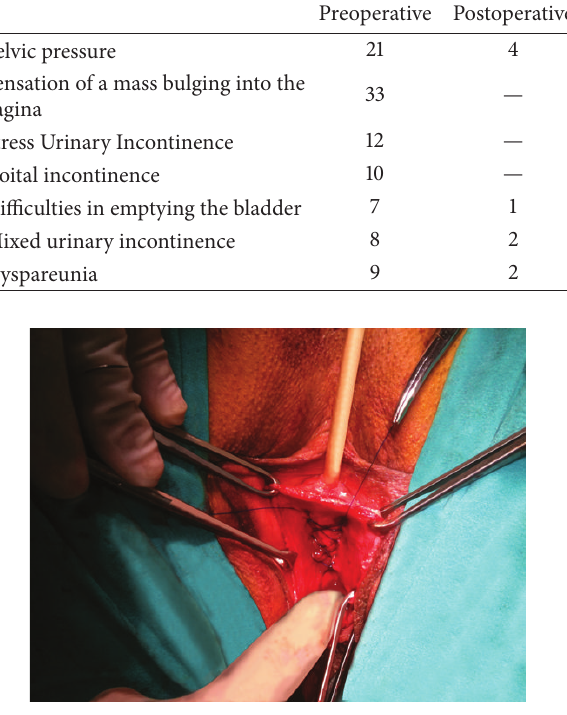
Figure 3: Surgical view of the ends of the